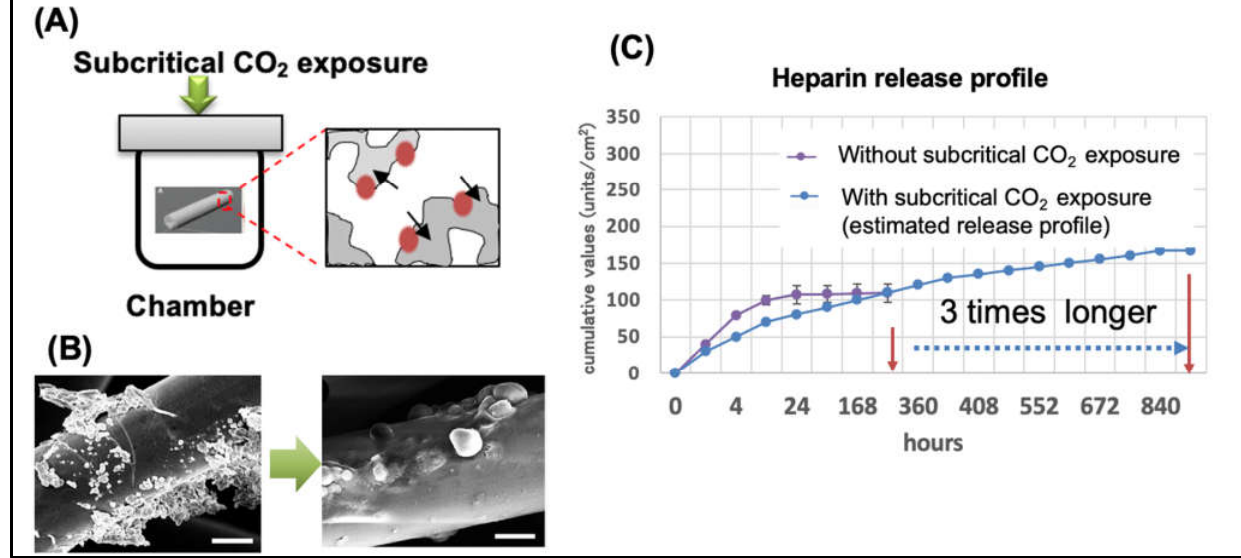
Figure 2. Subclinical CO 2 technique for long-term sustained release of heparin. ( A ) Adaptation of subclinical CO 2 exposure for TEVG. ( B ) Scanning electron microscopy (SEM) of HB-EGF on the scaffold. ( C ) Long release profile. Adopted with permission from Shinoka et al.